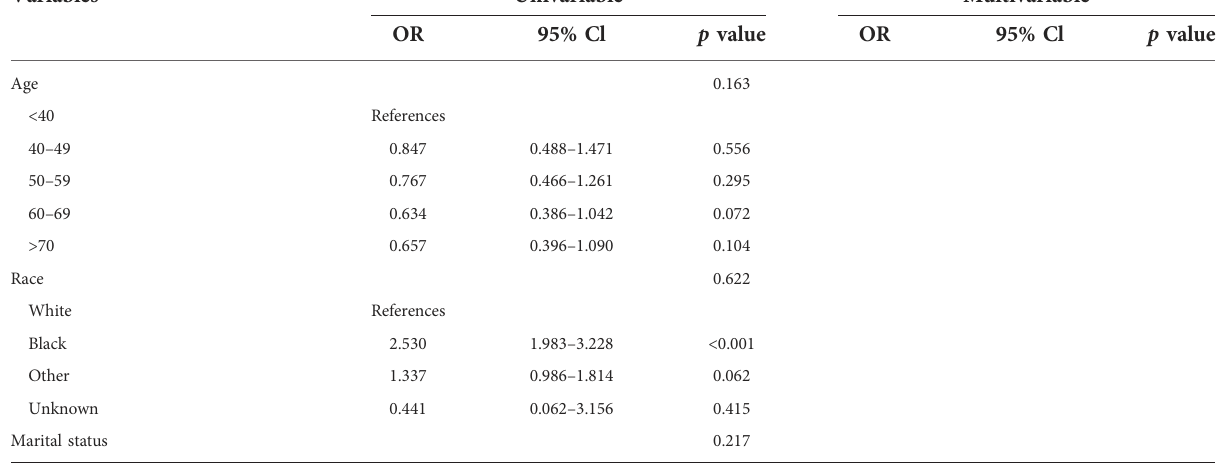
TABLE 3 Univariable and multivariable logistic regression for analyzing the associated factors for developing liver metastases in endometrial carcinoma cancer patients. Variables Univariable